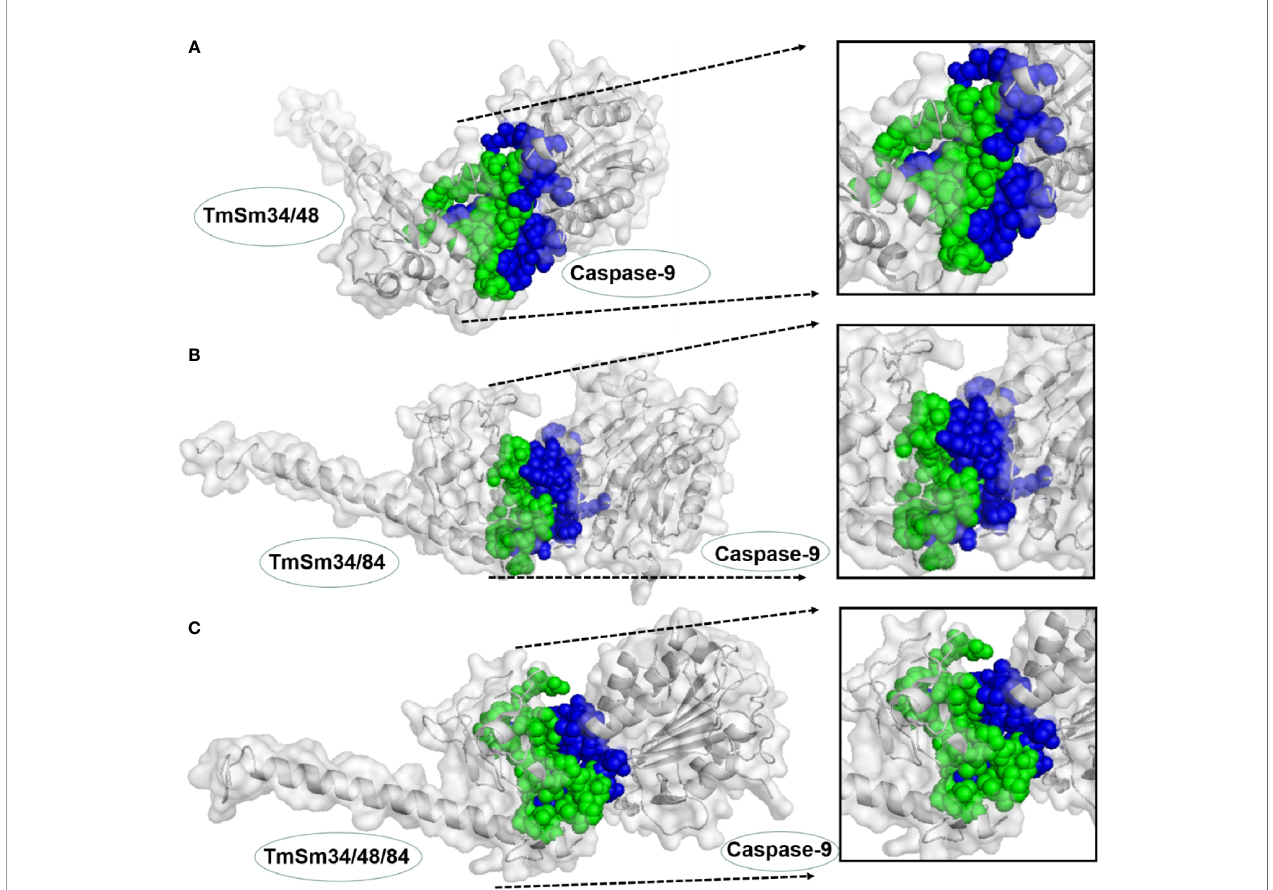
FIGURE 5 | Docking results for different TmSm proteins with caspase-9 were visualized by Pymol. (A) Docking results for TmSm34/48 with caspase-9. (B) Docking results for TmSm34/84 with caspase-9. (C) Docking results for TmSm34/48/84 with caspase-9. The interface areas were highlighted in green and blue.